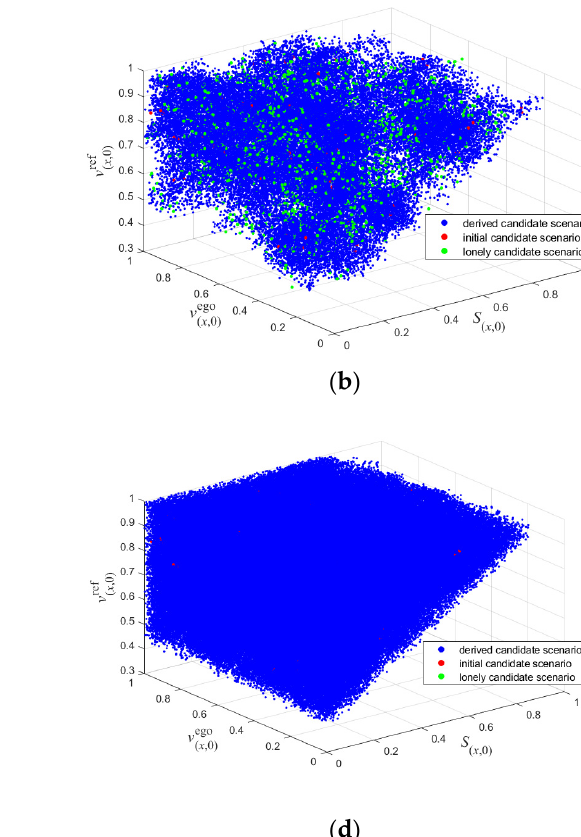
Figure 15. The number of the derived scenarios after each iteration.